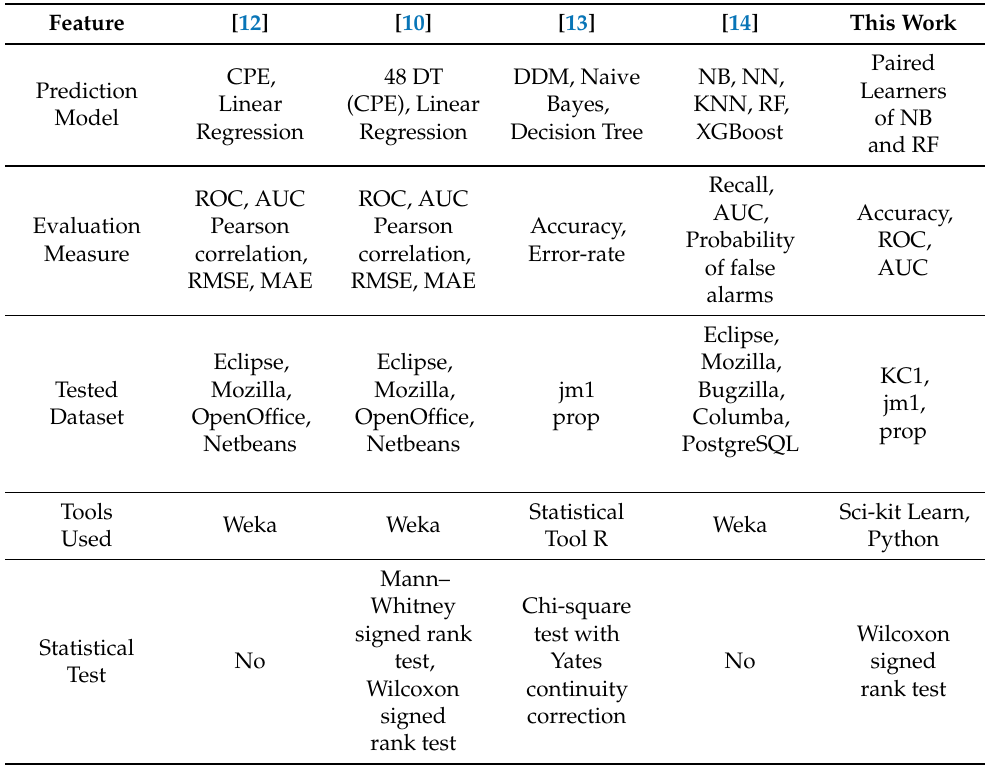
Table 1. Related